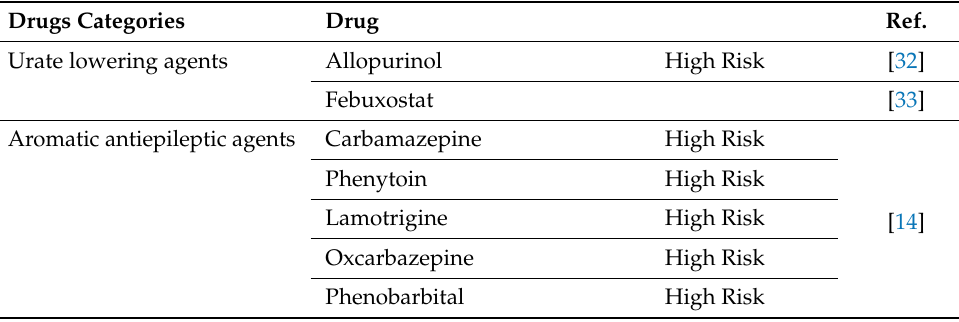
Table 1. Most frequent and newly reported culprit drugs in